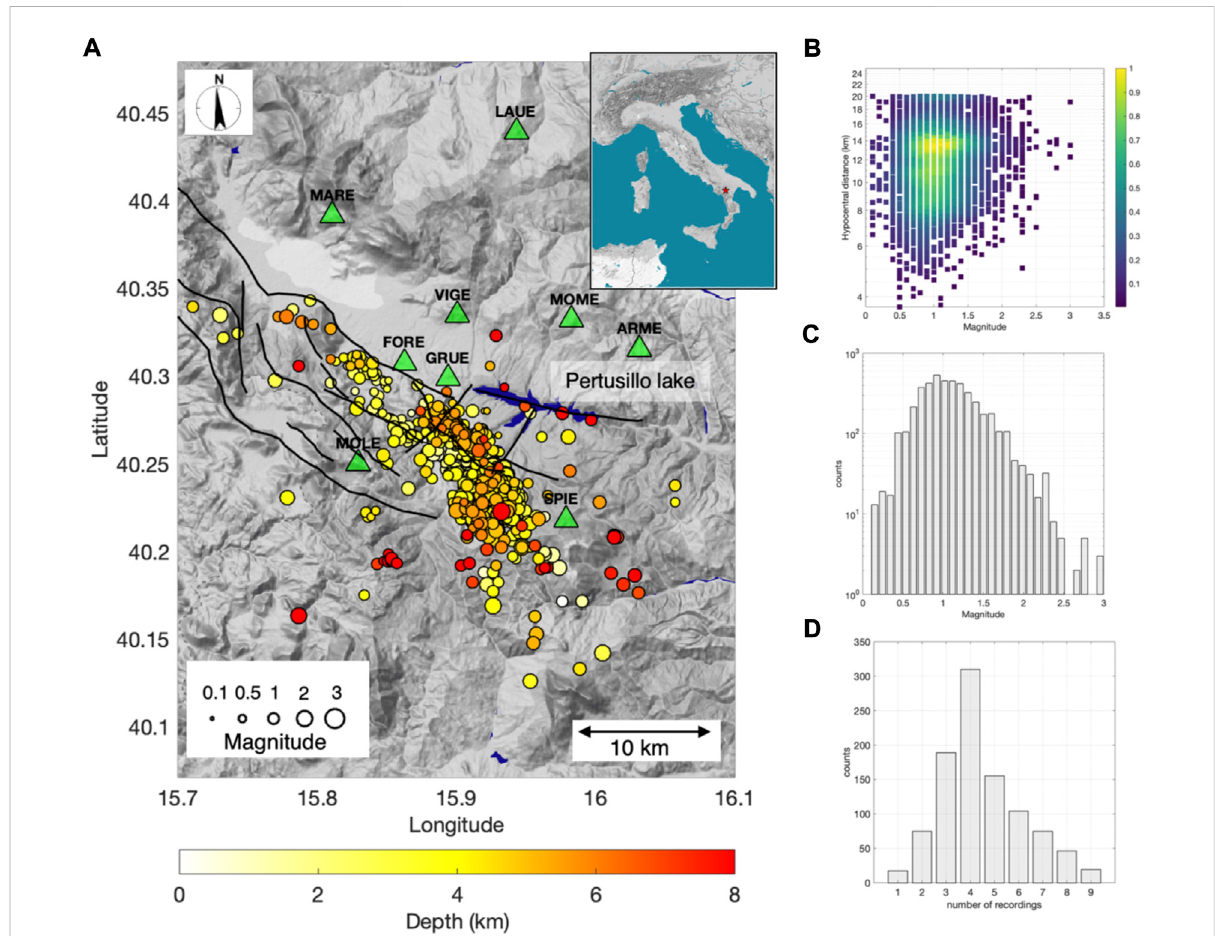
FIGURE 2 (A) Map showing the distribution of earthquakes (dots with dimensions according to the magnitude, and color according to the hypocentral depth) and the locations of seismic stations (green triangle). Monti della Maddalena fault system (MMFS; black lines). (B) Density plot, normalized between0and1,ofthemagnitude versus hypocentraldistance(i.e.,thelatterplottedonalogarithmicscale)fortherecordingsanalyzedinthisstudy. (C) Histogram showing the distribution of magnitudes for the considered events. (D) Histogram showing the number of recordings per event (i.e., the number of stations that recorded an